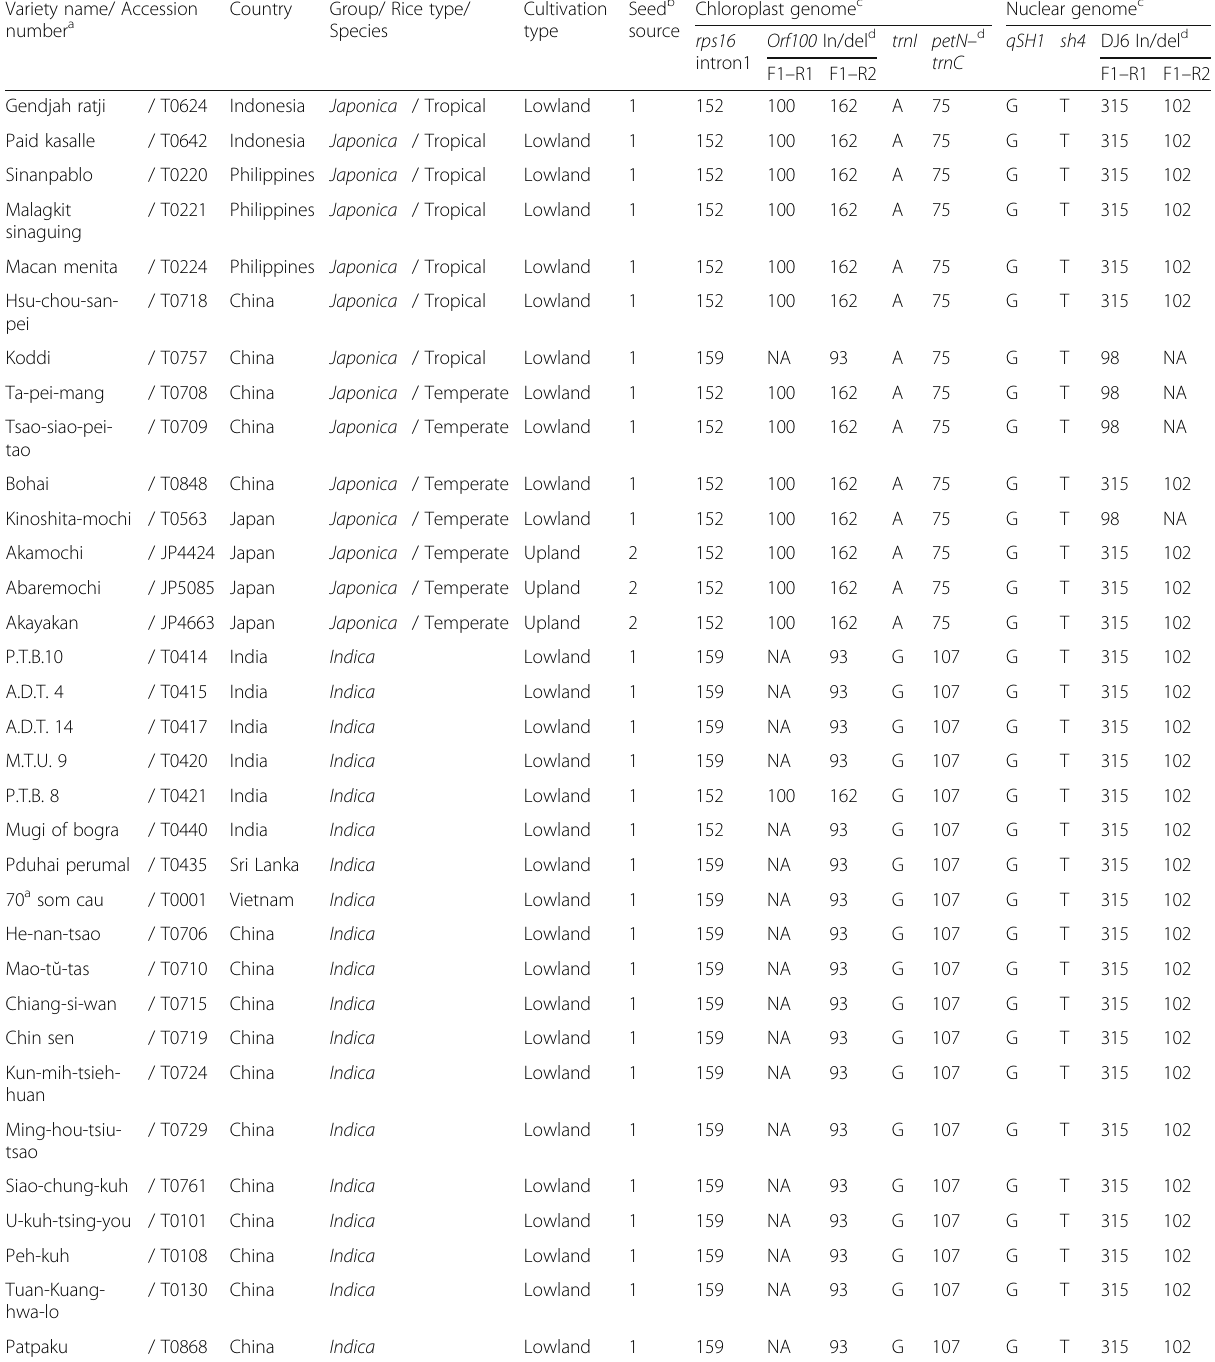
Table 1 DNA genotype of modern rice accessions examined in this study Variety name/ Accession number